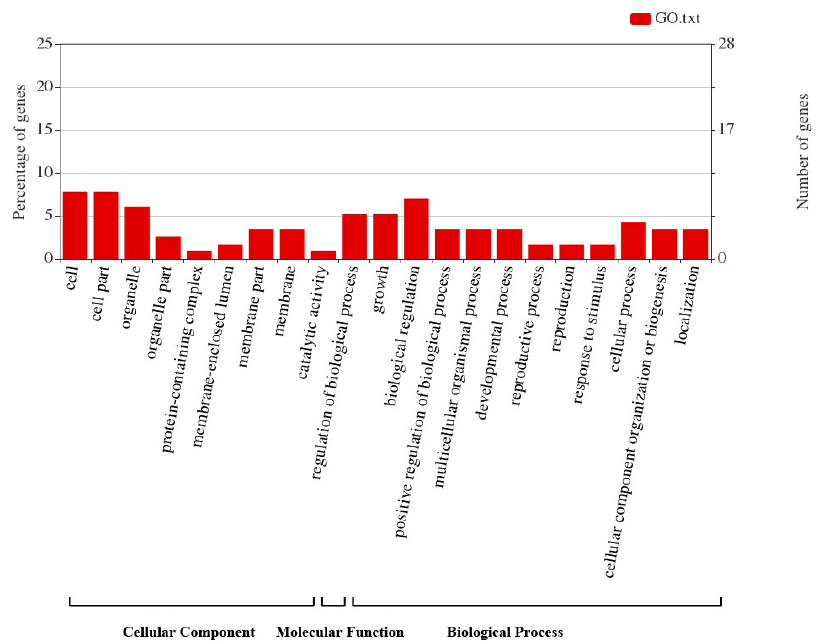
Figure 5. GO annotation analysis of PbrSAUR gene family and these functions divided into three groups cellular components, molecular function, and process.